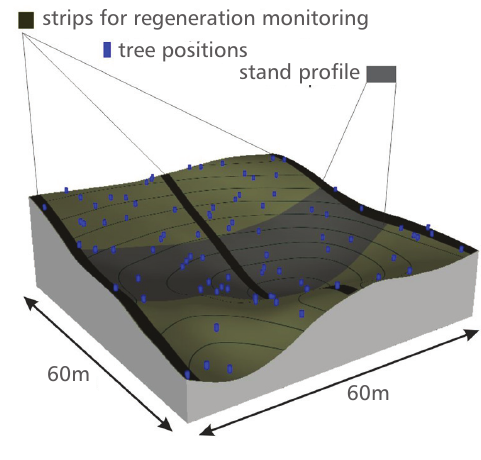
FIGURE 2. Digital terrain model (DTM) of the experimental plot with basic measuring elements